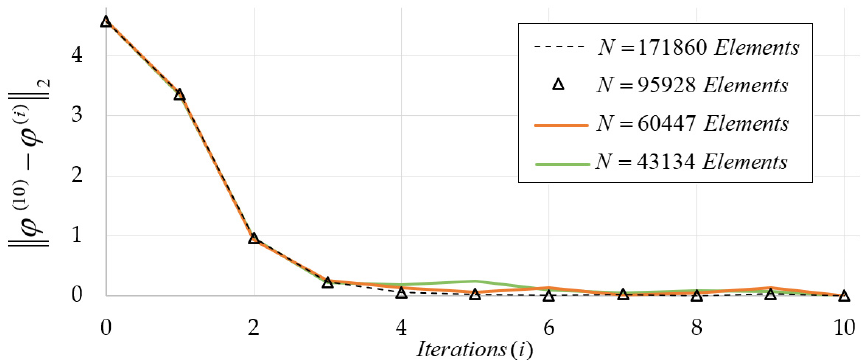
Figure 14. Convergence of the iterative scheme used to obtain a convergent solution by the present FEM scheme in the case of waves and current scattered by a cylinder. The iteration numbered 0 corresponds to the starting solution obtained without the current.